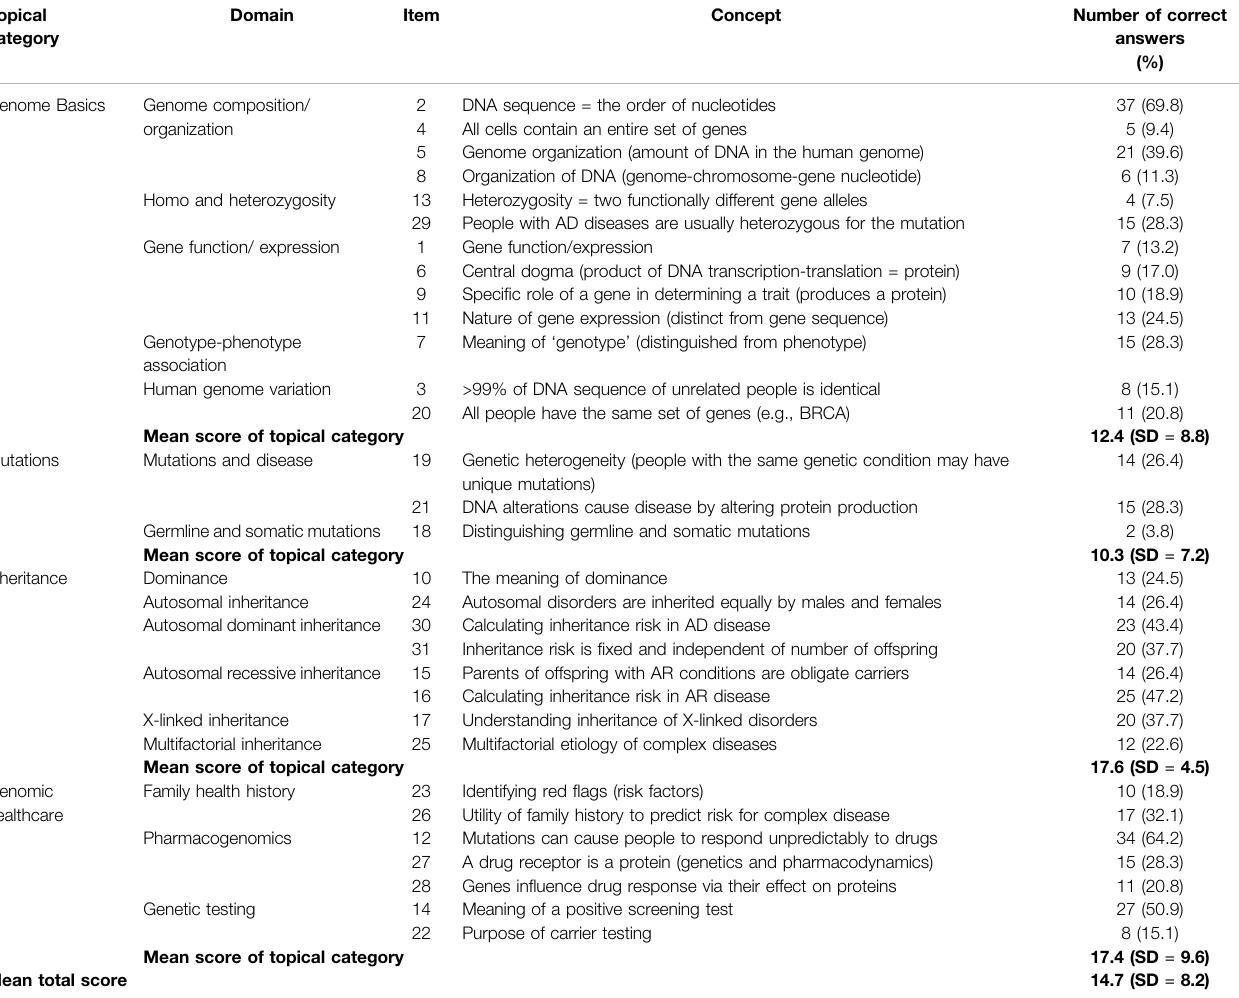
TABLE 4 | GNCI © item scores, topical category scores and total score. Topical